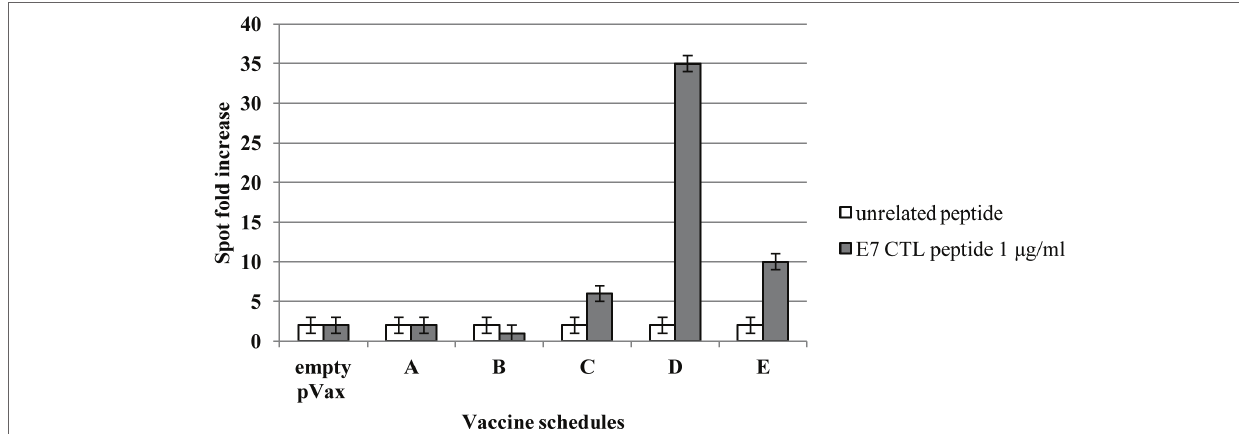
FIGURE 7 | Cell-mediated immune responses in vaccinated mice. C57BL/6 mice were immunized according to schedule and procedures as in Materials and Methods. IFN-gamma production was measured in an ELISPOT assay after specific antigenic stimulation with the E7 peptide RAHYNIVTF (aa 49–57). A, empty pVax prime/mock hairy root extract boost; B, mock hairy root extract prime/mock hairy root extract boost; C, pVax-E7*-SAPKQ prime/pVax-E7*-SAPKQ boost; D, pVax-E7*-SAPKQ prime/E7*-SAPKQ extract boost; E, SAPKQ extract prime/SAPKQ extract boost. Data are presented as fold-increase responses to the E7 peptide in comparison with mice vaccinated with empty vector/irrelevant root extract, and they represent the means of all of the mice in the groups ±